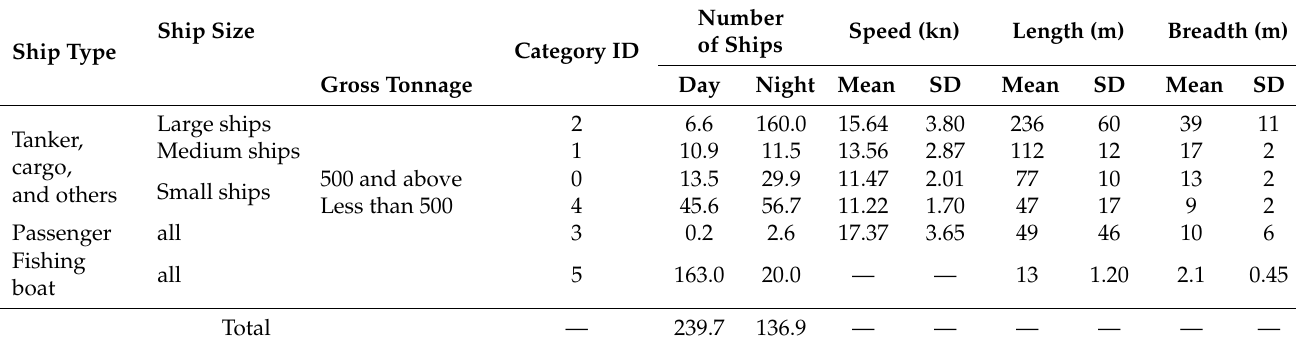
Table 1. The number of ships and ship statistic in the